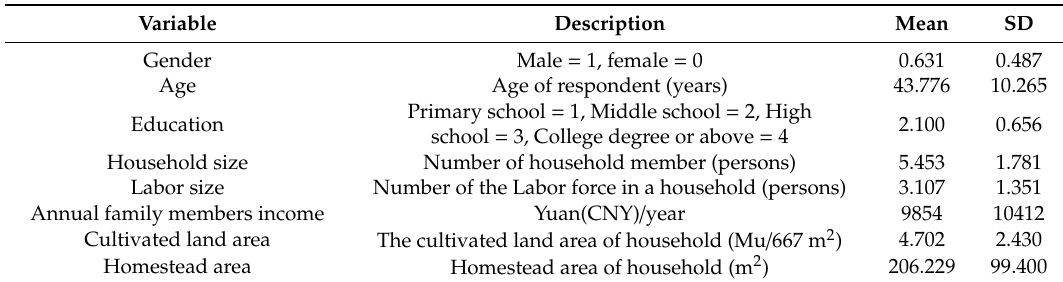
Table 2. Respondents’ demographic